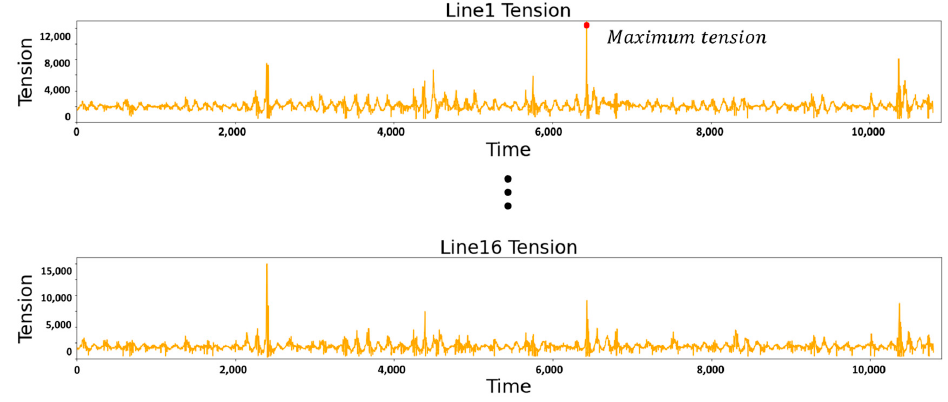
Figure 6. The maximum tension on the 16 mooring lines in the time–domain analysis for 3 h.